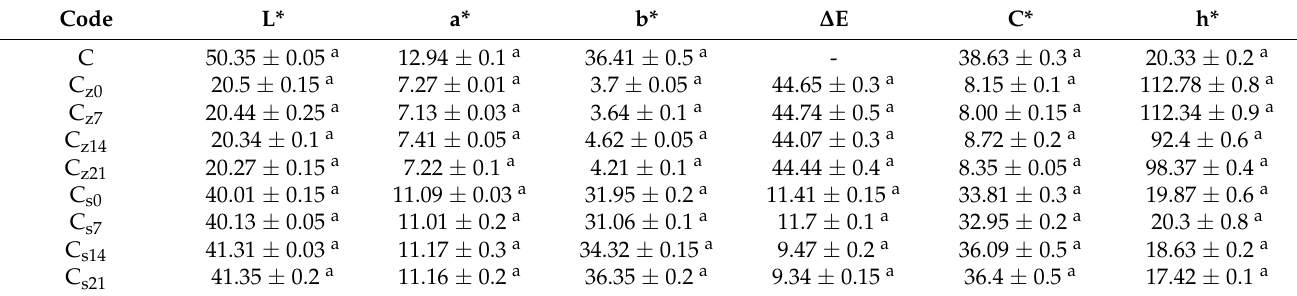
Table 2. Color parameters of